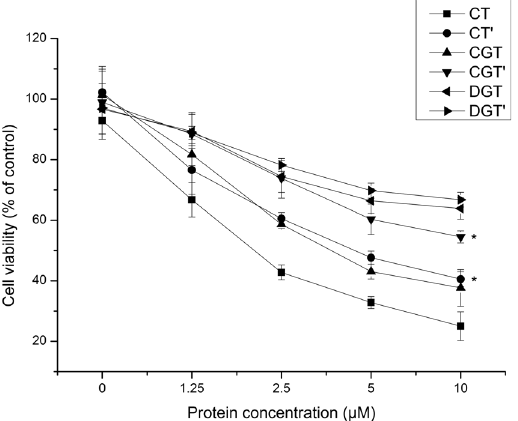
Figure 4. Cytotoxic activity of different TRAIL IBs in the MTT assay. CT, CGT and DGT are IBs produced by the wt, GroEL/ES + and GroEL/ES − strains, respectively. CT’, CGT’ and DGT’ are the corresponding IBs after in vivo refolding. The viability of NCI-H460 cells co-cultured with TRAIL IBs at different concentrations (1.25, 2.5, 5 or 10 μ M) was measured. Data are presented as the mean ± SD ( n = 6; * p < 0.05 versus the corresponding group before in vivo